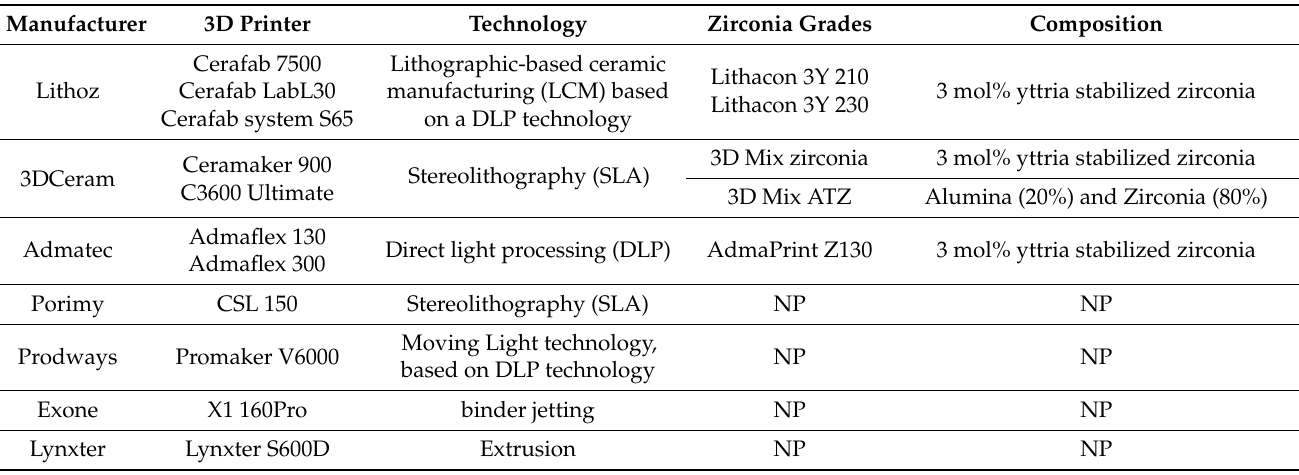
Table 2. 3D printers available for the manufacturing zirconia